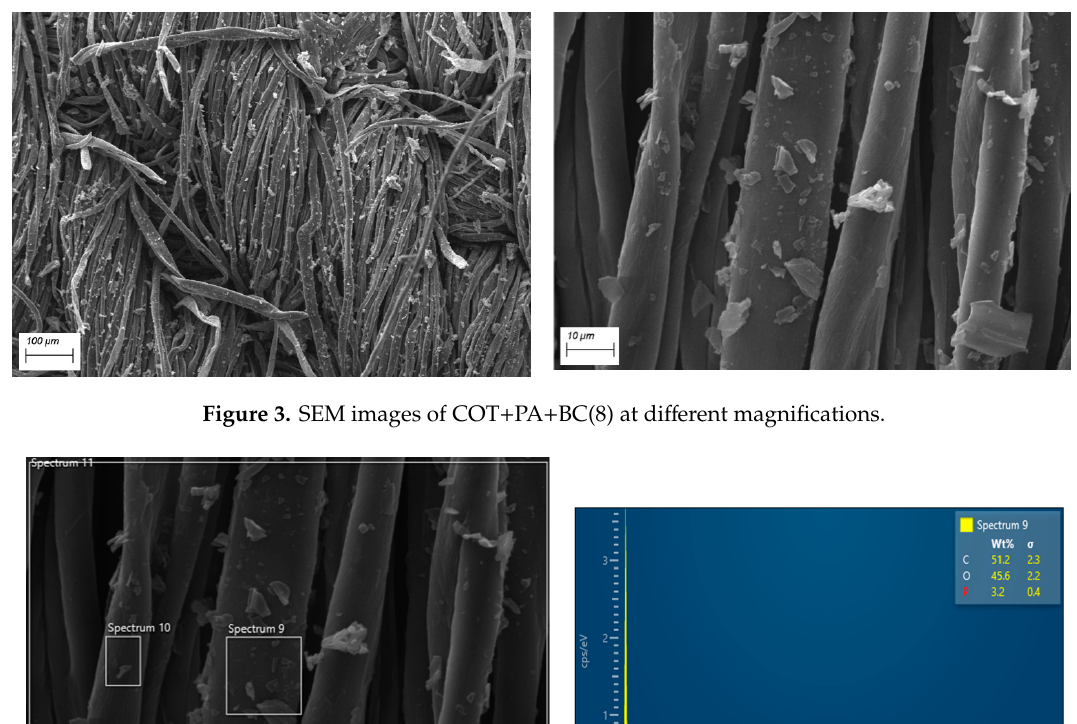
Figure 2. SEM images of untreated cotton at different magnifications.